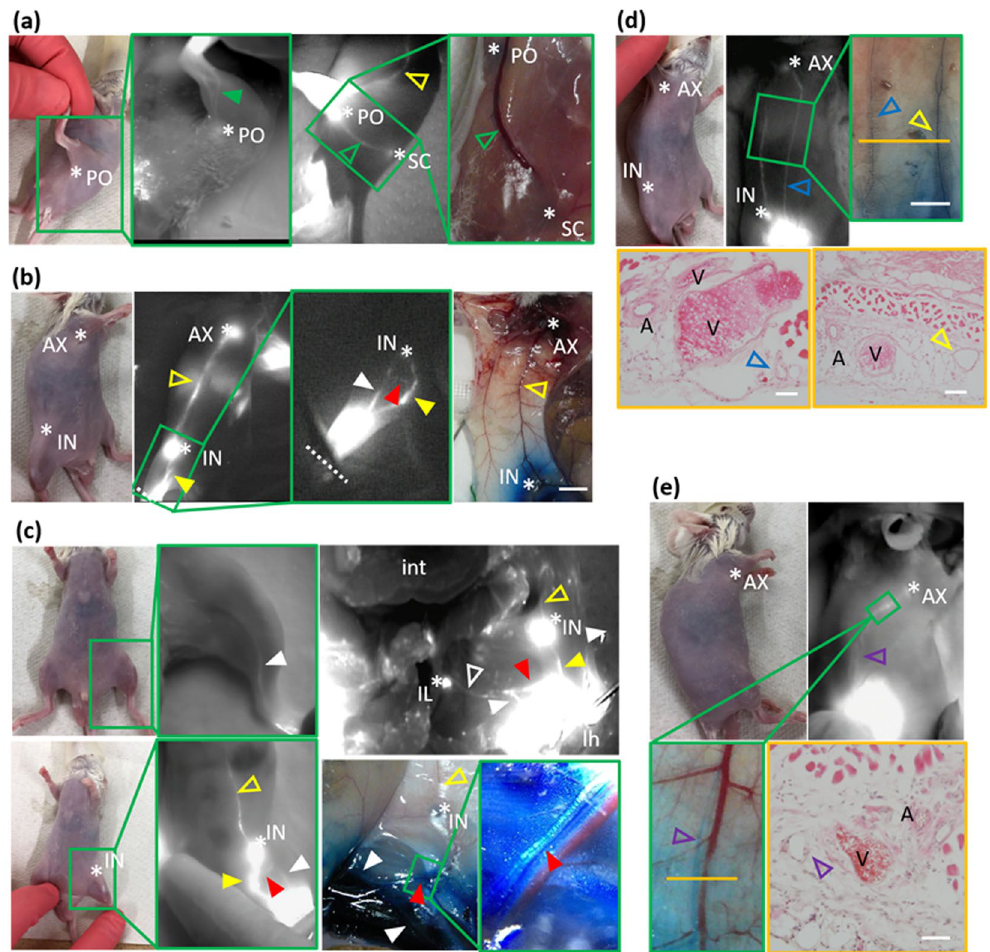
Figure 1. Lymphatic systems detected by visual images, NIRF, and photomicrographs. Visual images of mice on ( a ) to ( e ) revealed each location of right NIRF images. Green large boxes showed the high magnification of each site in green small boxes. ( a ) The superficial lateral system passed the calf muscle (closed green arrowhead) through the popliteal lymph node (LN) and onto the sciatic LN (open green arrowhead), left hindlimb, injection site; green arrow in Fig. 2. ( b ) The superficial medial system passed into the thigh and through the inguinal LN (closed yellow arrowheads), and then ran into the axillary LN (open yellow arrowheads), right hindlimb. Injection site; yellow arrow in Fig. 2, dashed white line; the level of the ankle, Scale bar; 1 cm. ( c ) Upper images; the deep medial system passed into the thigh and entered the abdominal cavity (closed white arrowheads), then ran into the iliac LN (open white arrowheads), left hindlimb. The right image was obtained after dissection of the abdominal cavity. Injection site; gray arrow in Fig. 2. Bottom images; another lymphatic that contributes to the deep medial system (closed red arrowheads) was detected between the inguinal and iliac LNs by the injection of dyes at the site indicated by the yellow arrow in Fig. 2. ( d ) A newly detected lymphatic from the lower abdomen to the axillary LN (open blue arrowhead), left lateral position. Injection site; blue arrow on the left figure in Fig. 2. Hematoxylin and eosin (H&E)-stained images; cross-sectional images at the level of the orange line in the upper right image. Scale bars; upper right 1 cm, bottom left 50 µ m, bottom right 100 µ m. ( e ) Lymphatics arising from the lower back and running to the superficial axillary LN (open purple arrowheads), left lateral position. A H&E image was obtained at the level of the orange line in the left bottom image. Injection site; purple arrow on the right fig. in Fig. 2. Scale bar; 50 µ m. * AX; axillary LN, * IN; inguinal LN, * IL; iliac LN, * PO; popliteal LN, * SC; sciatic LN, A; artery, V; vein, int; intestine, lh; left